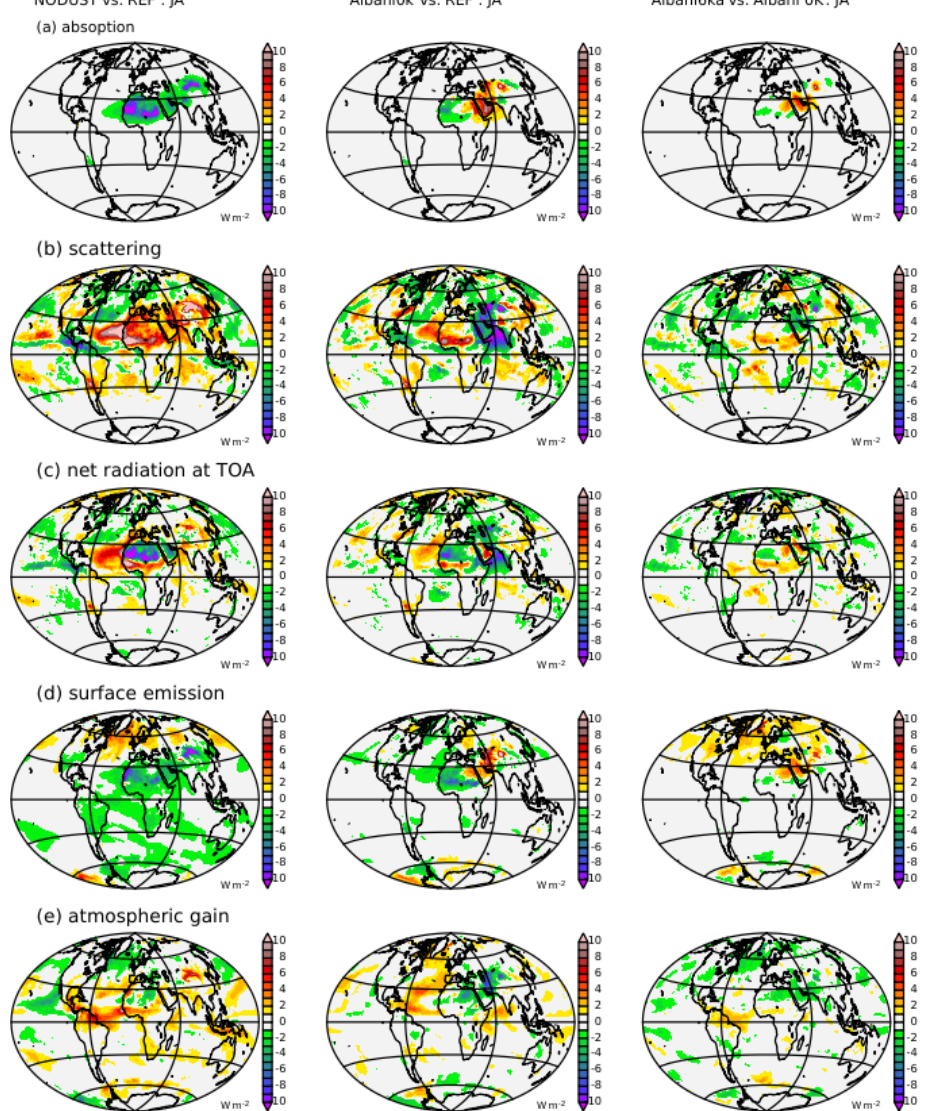
Figure 11. Impact of dust on top of the atmosphere radiation considering the decomposition of Taylor et al. (2007) for shortwave radiation. The first part of the figure refers to January–February averages and the second part to July–August averages. (a) The effect of changes in atmospheric absorption, (b) the effect of atmospheric scattering and (c) the change in net radiation (SW+LW) at the top of the atmosphere (TOA), and for longwave the estimate of (d) the change in surface emission due to temperature (Planck emission) and (e) the effect of changes in the atmospheric heat gain, which represent the aggregated effect of changes in atmospheric lapse rate, change in atmospheric water vapour and changes in clouds. From left to right the different panels show the results for the NODUST, the Albani0k and the Albani6k simulations, with reference to MHREF for NODUST and Albani0k and reference to Albani0k for Albani6k. All terms are positive downward to directly reflect the relative impact of each of these terms on the atmospheric radiative budget et the top of the atmosphere. The change in net radiation at TOA is also the sum of all the other terms, given that the effect of changes in surface albedo due to changes in leaf area index is negligible (not